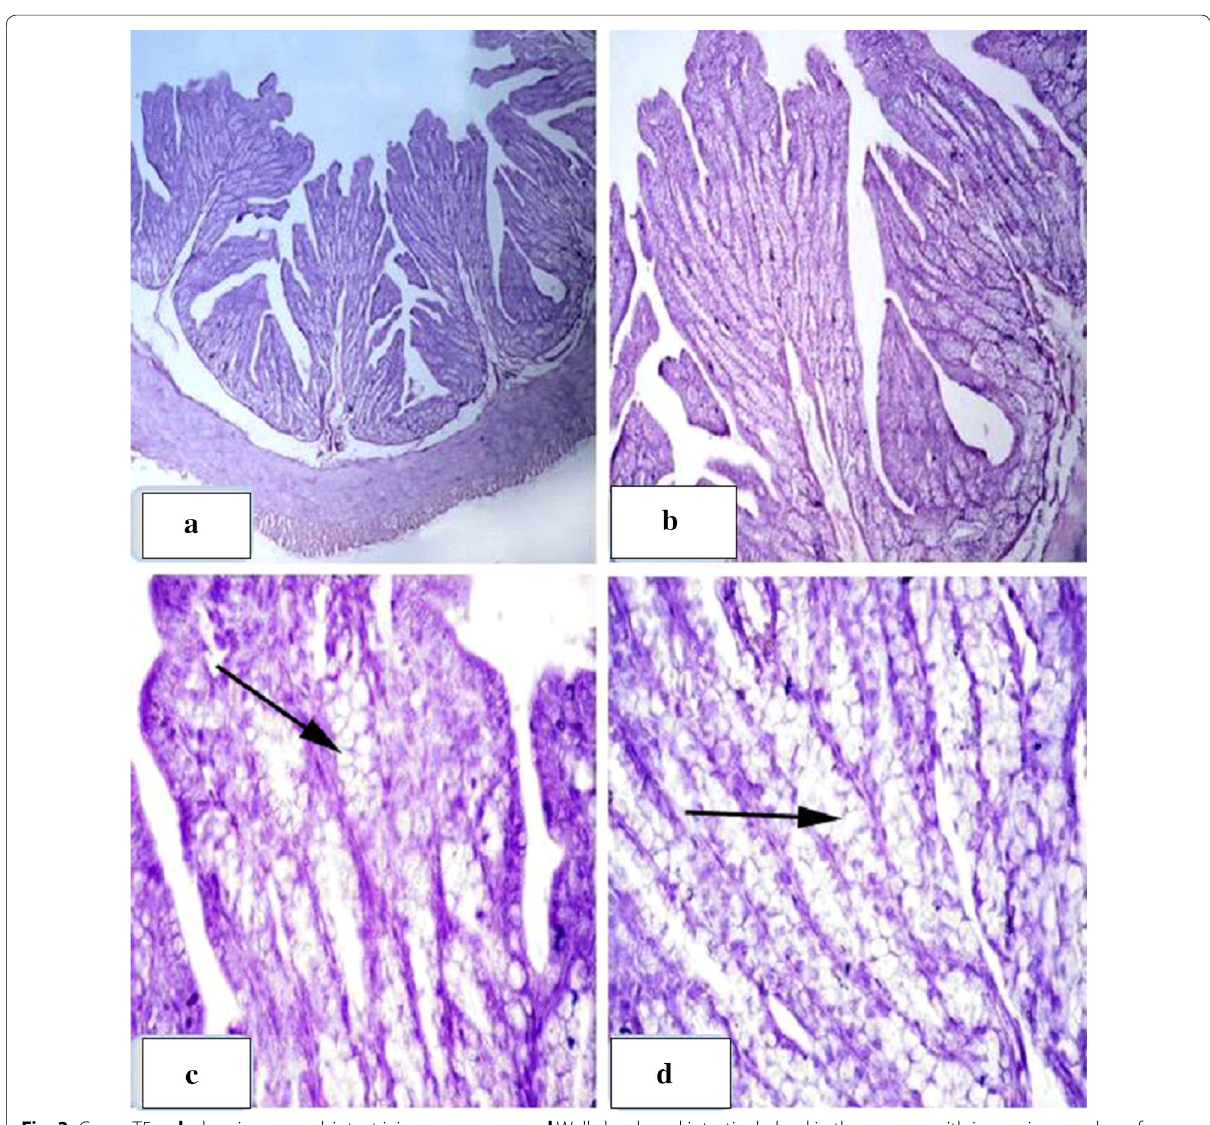
Fig. 3 Group T5: a , b showing normal, intact jejunum mucosa. c , d Well‑developed intestinal gland in the mucosa with increasing number of goblet cells